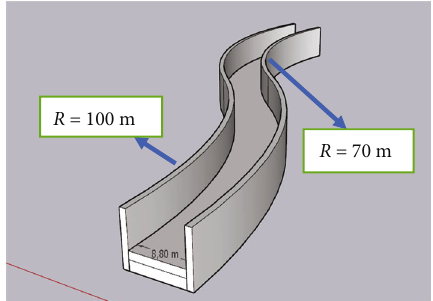
Figure 2: Bottom outlet with two curvatures R = 70m and R = 100m .